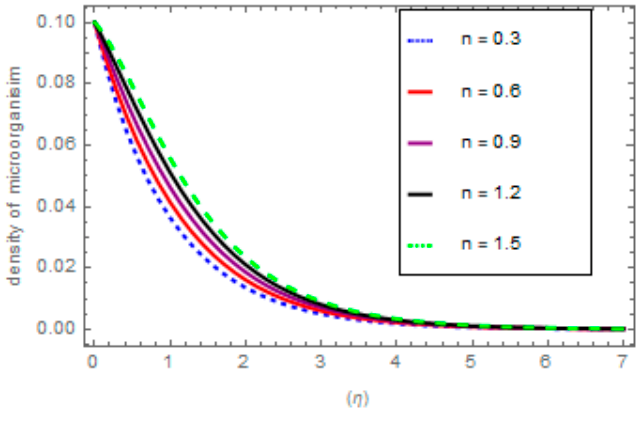
Figure 7. Upshot of n on h ( η ) .